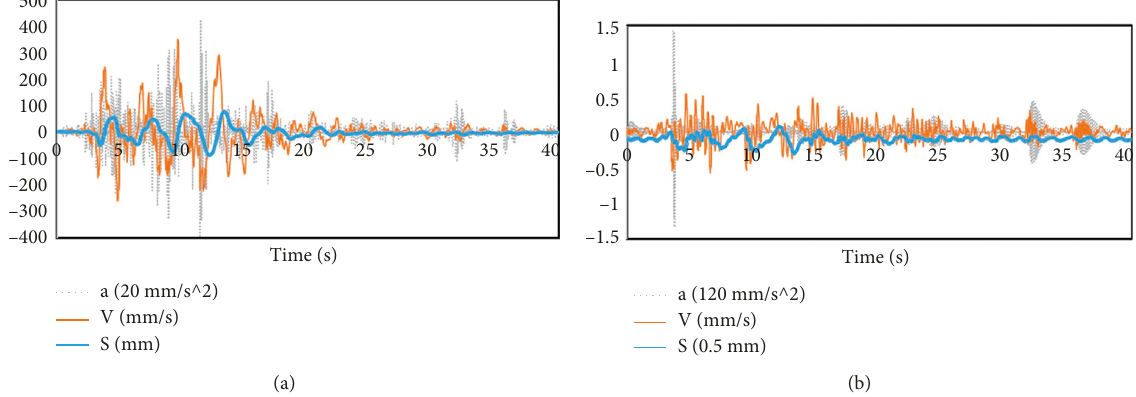
Figure 56: Time course curves of bearing deformation displacement, velocity and acceleration when N94 is input from Y direction. (a) Horizontal deformation. (b) Vertical